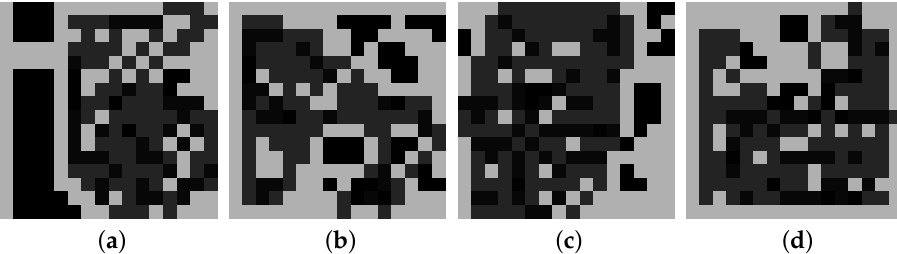
Figure 8. Solutions learned to a coverage problem for the environments above. The maps correspond one-to-one to those above. The lighter the gray color, the more entropy remains at this position at the end of the trajectory. Each subfigure is a different